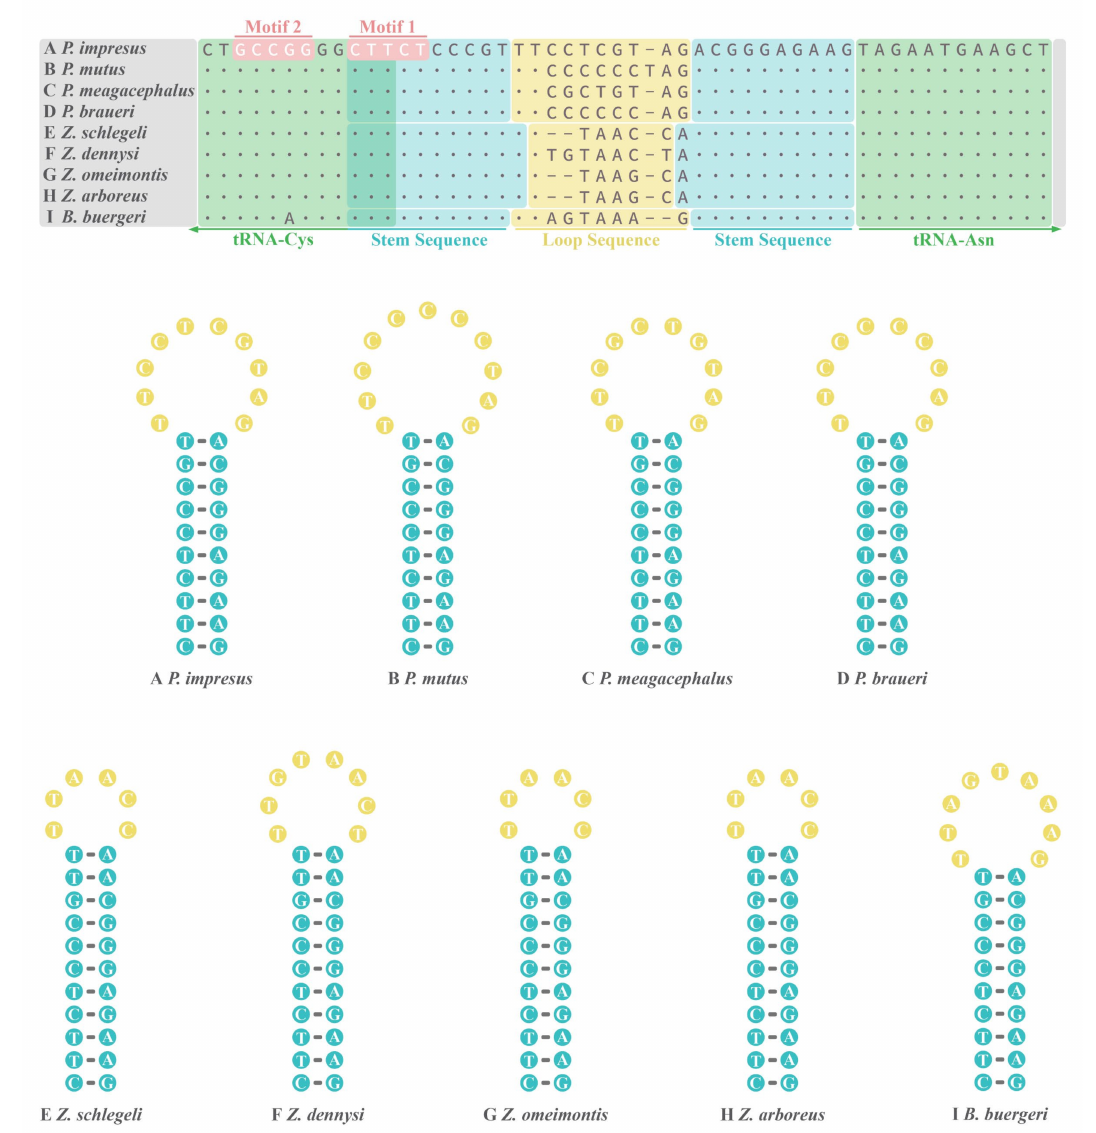
Figure 4. Putative secondary structures and sequence alignments of origin of replication on the light strand (O L ) in the mitogenome of nine